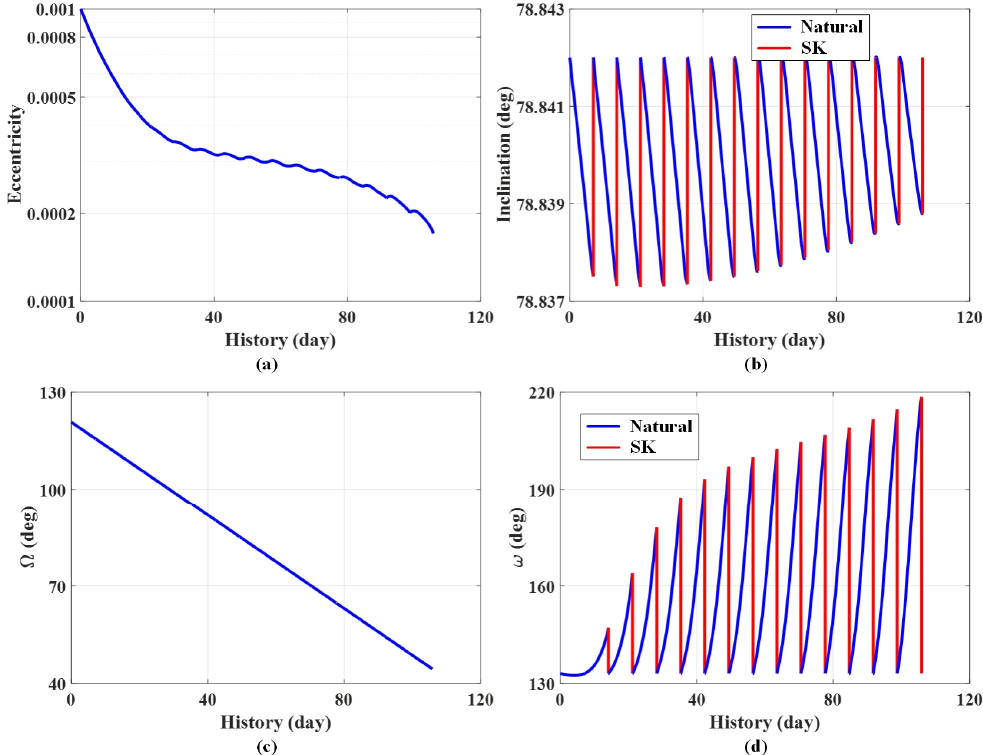
Figure 11. Evolutions of orbital elements, for a = 1.2 R E , e = 0.001, i = 78.842 ° , Ω = 120.7575°, and ω = 133.07 ° . Subplots ( a – d ) show the evolutions of the eccentricity, inclination, longitude of the ascending node and argument of periapsis, respectively.